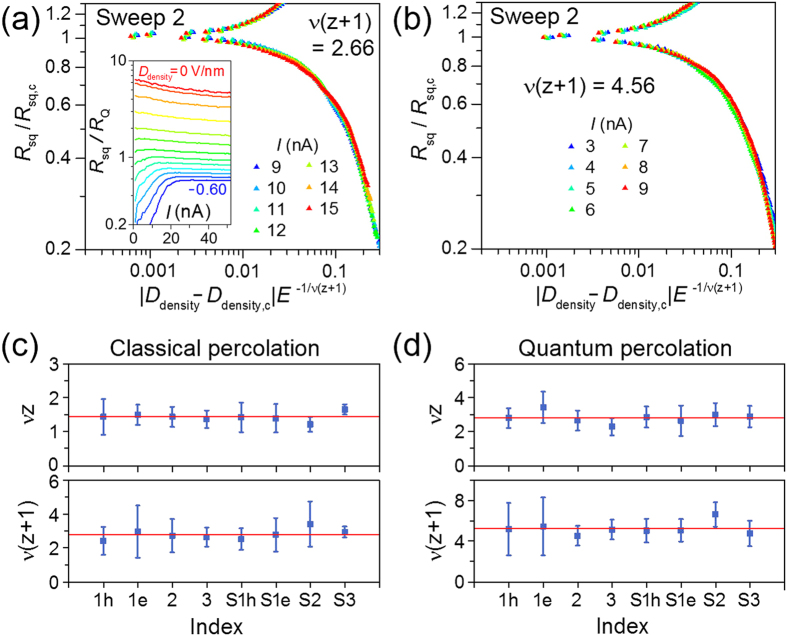
Scaling of square resistance for different electric fields and critical-exponent products for various gate sweeps.Finite-size scaling analysis of electric field dependences of Ddensity-driven transition for the gate sweep 2, which yields the best collapse with v(z + 1) = 2.66 for I = 9–15 nA in (a) or v(z + 1) = 4.56 for I = 3–9 nA in (b). Inset of (a), bias current dependence of Rsq at different doping levels (Ddensity, from 0 to −0.60 Vnm−1, in steps of 0.05 Vnm−1). Critical-exponent products vz and v(z + 1) evaluated at various critical points for (c) the classical percolation regime and (d) the quantum percolation regime. Red lines represent average values. The characters ‘h’ and ‘e’ in the sweep indices stand for the hole and electron side, respectively.